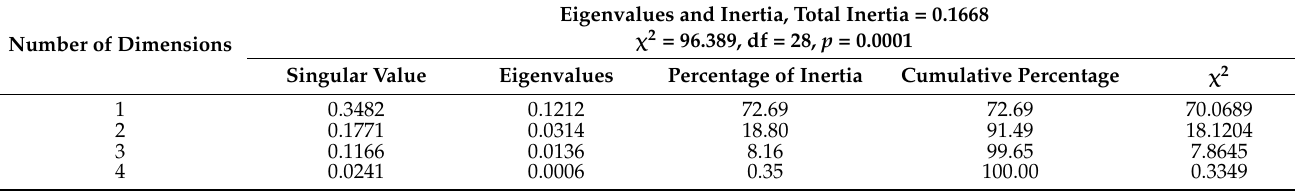
Table 2. Information resources’